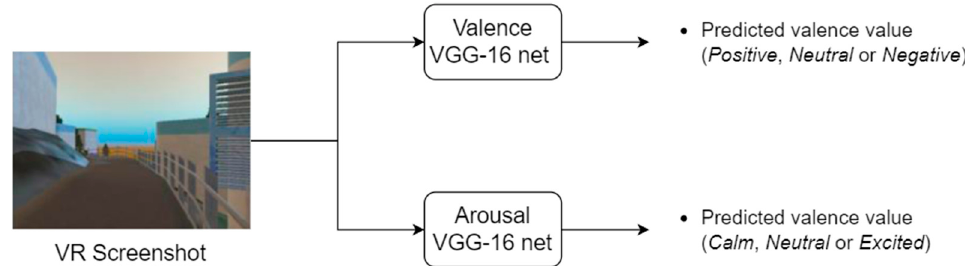
Figure 3. Simpli fi ed image sentiment analysis pipeline. The predicted valence and arousal values are fed to the fusion